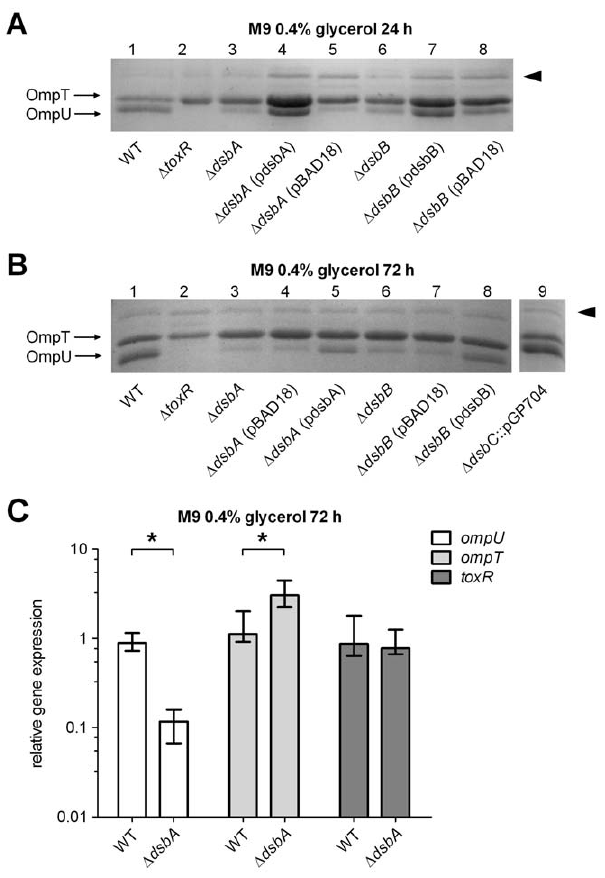
Figure 1. dsb knockout mutations and porin production in V. cholerae P27459-S. Panel A, B shown are OMP profiles on SDS-PAGE of WT, D toxR , D dsbA , D dsbA (pBAD18), D dsbA (pdsbA), D dsbB , D dsbB (pBAD18), D dsbB (pdsbB) and dsbC ::pGP704 (only panel B) strains derived from cells grown for 24 h and 72 h in M9 glycerol, respectively. Arrows mark OmpU and OmpT. As a negative control, D toxR mutant strain showed no production of OmpU and derepressed OmpT protein level. The arrowhead on the right indicates a ToxR independent protein band used as loading control. Panel C, shown are qRT-PCR analyses of WT and D dsbA strain for ompU , ompT and toxR transcripts. Fold change ratios were calculated by comparing cDNA levels of genes of interest and the reference gene rpoB , derived from cells grown in M9 glycerol for 72 h. Data are presented as median fold change and the error bars indicate the interquartile range of each data set. Experiments were performed with at least six independent samples, utilizing the Mann- Whitney U test, P , 0.05.